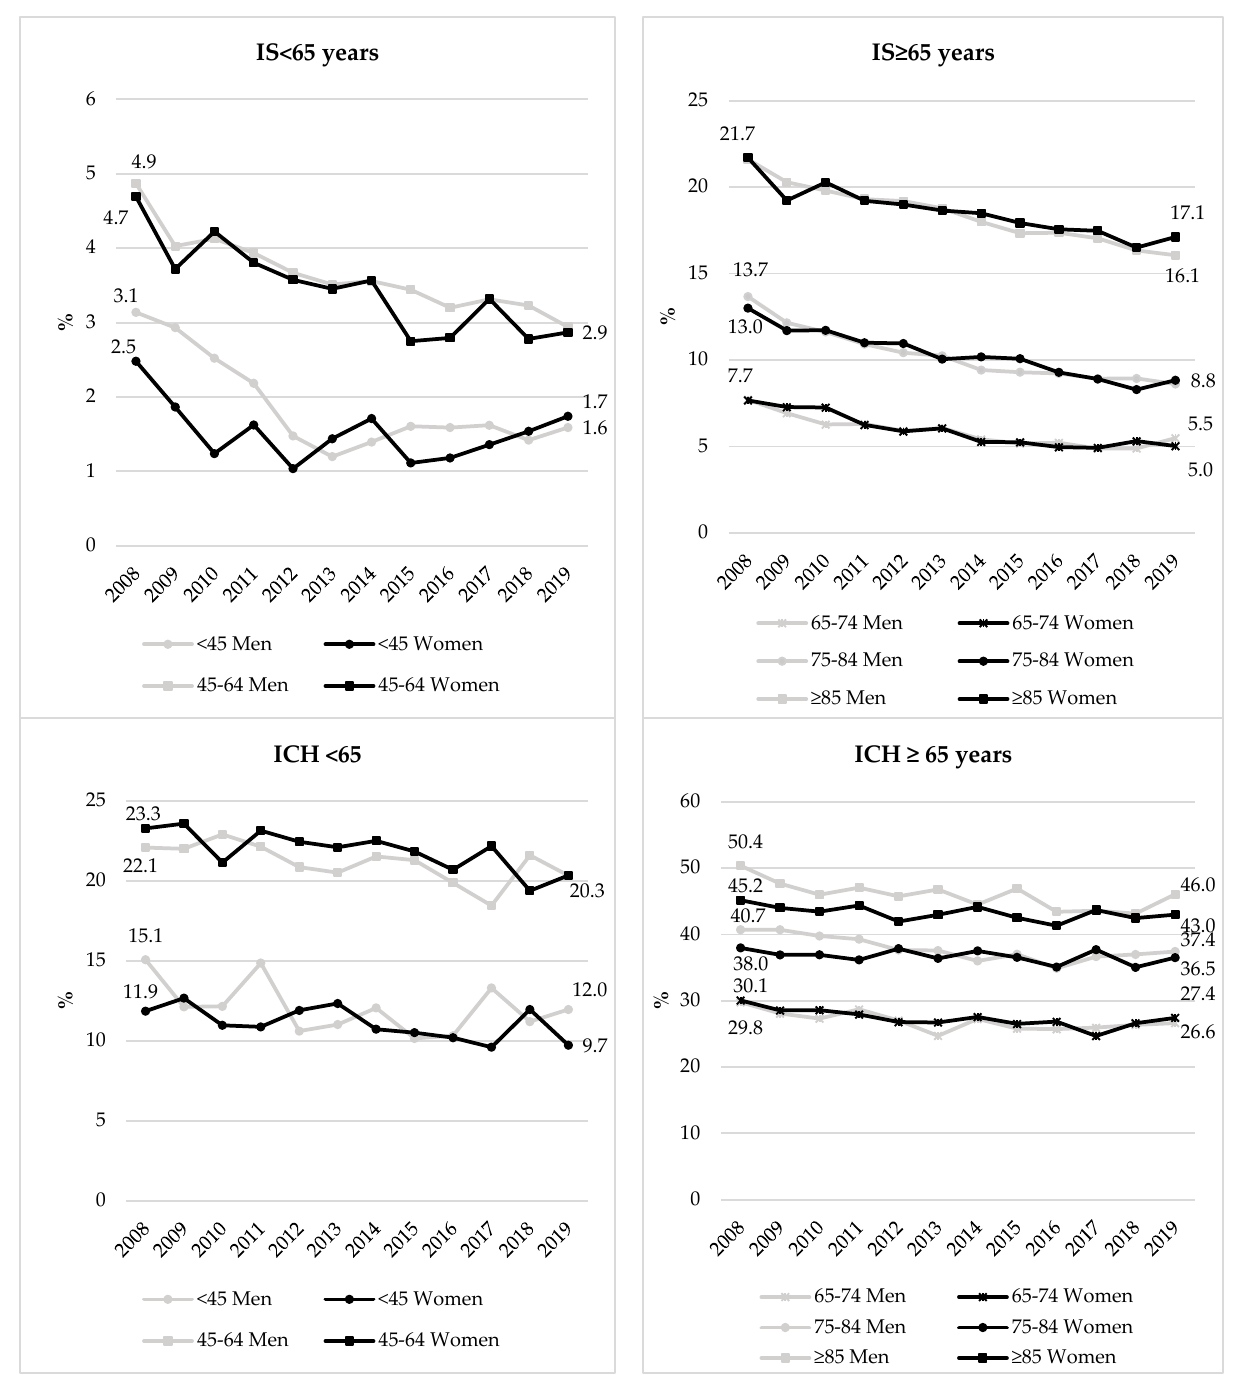
Figure 4. Time trends in the in-hospital case fatality rates (%) for ischemic stroke (IS) and intracerebral hemorrhage (ICH) in France according to sex and age group. Gray: men; black: women.